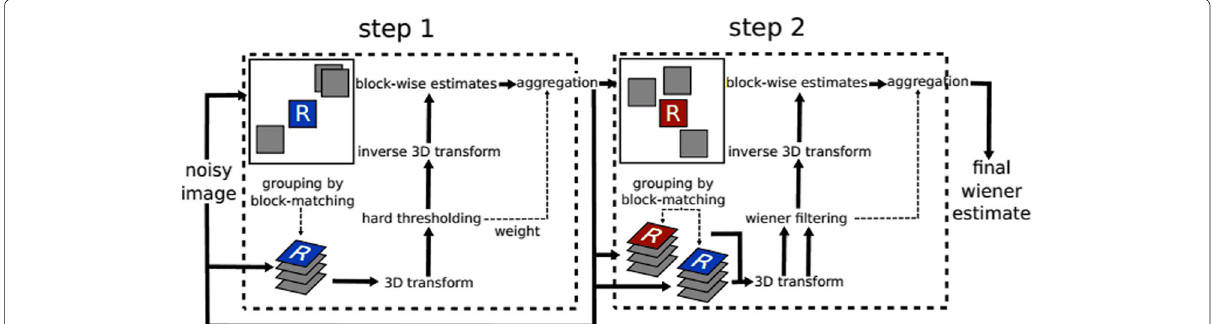
Fig. 9 BM3D filtering: the two steps of BM3D filtering